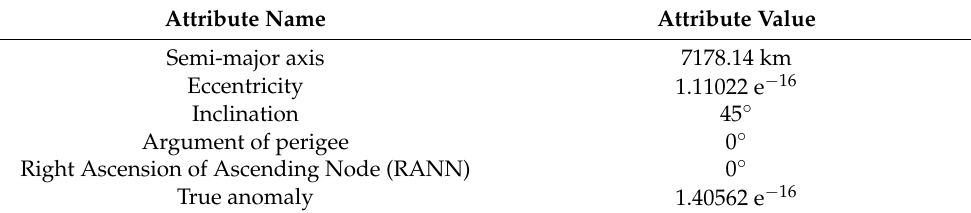
Table 2. Relevant parameters of the LEO satellite orbit.